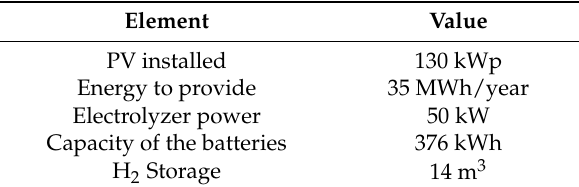
Table 6. Values of the most competitive scenario.